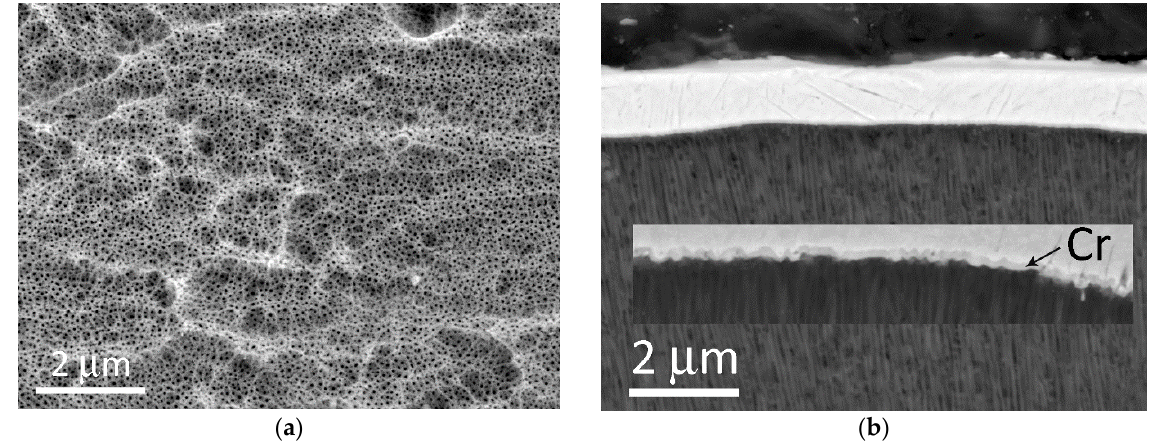
Figure 4. ( a ) Plan view of unpolished AAO without metallization. ( b ) Cross-section view of unpolished AA#1 with Cr and Cu layers deposited by magnetron sputtering.